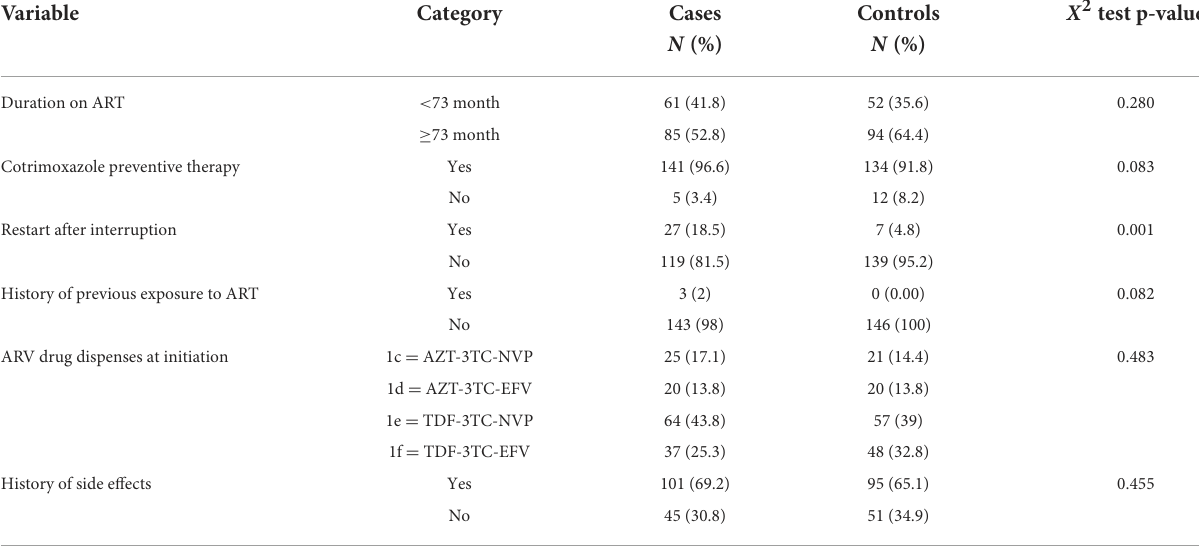
TABLE 3 Drug-related information of patients with HIV treated at MTUTH in 2020.